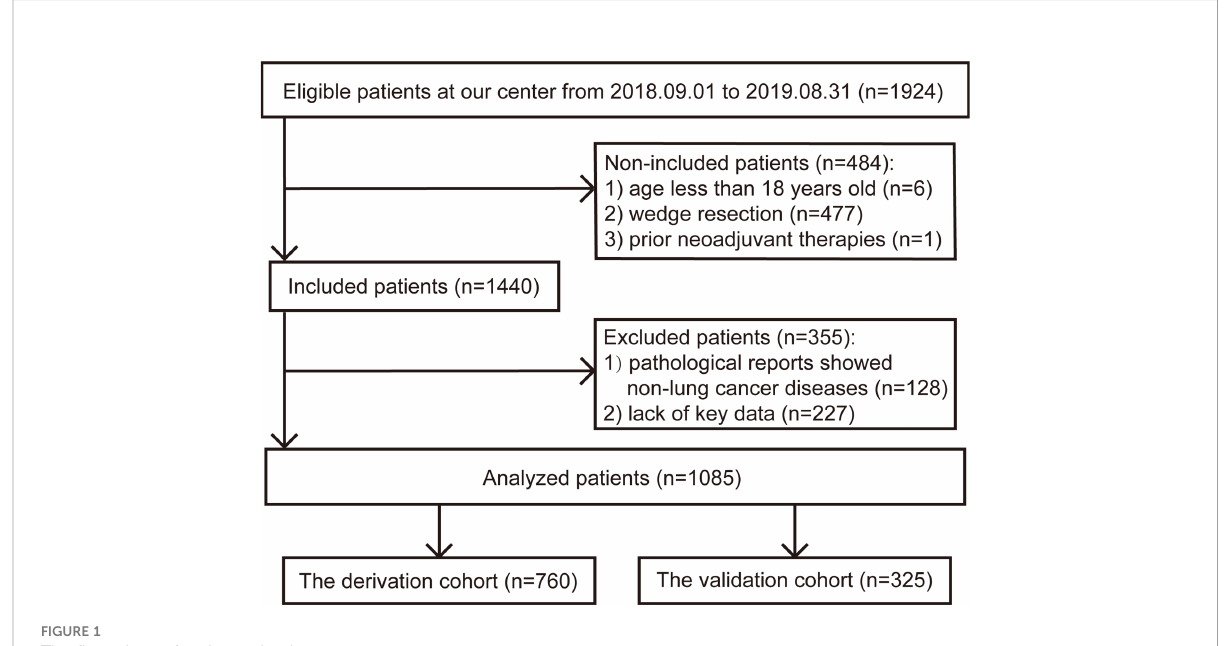
FIGURE 1 The fl ow chart of patient